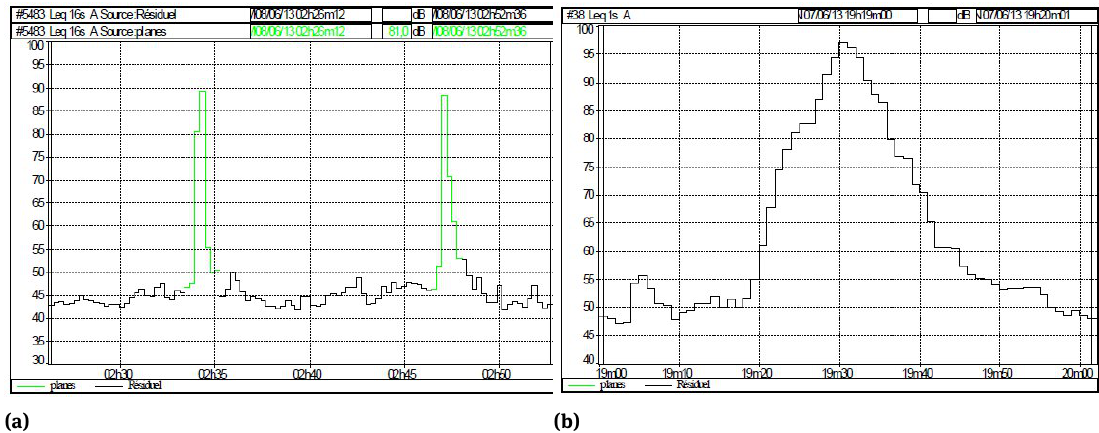
Fig. 3. 2 Noise signature of a typical Air Bus Take off procedure at the elementary school measurement location.